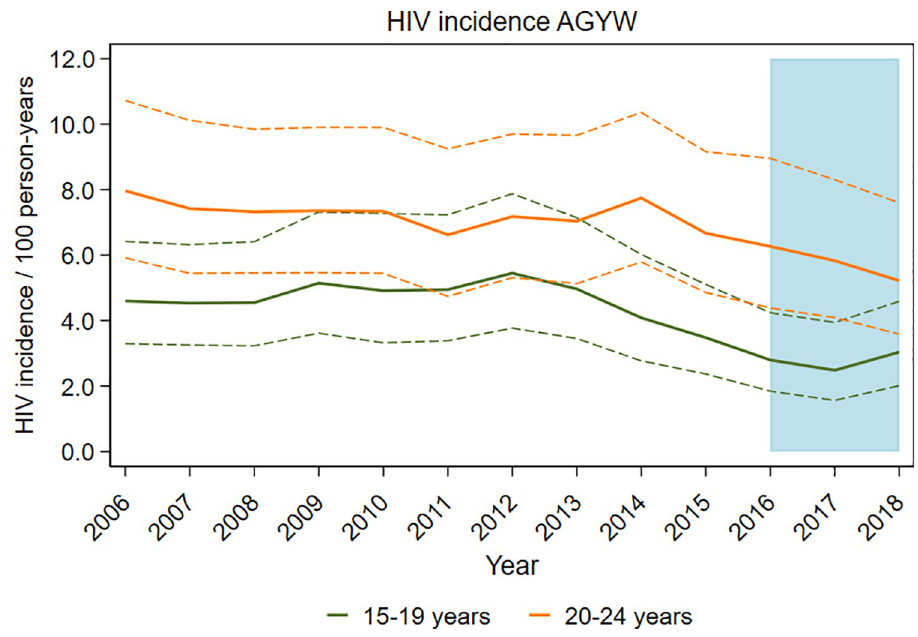
Fig 1. HIV incidence rates over time among AGYW with 95% CIs, in uMkhanyakude, South Africa. AGYW AU : AbbreviationlistshavebeencompiledforthoseusedinFigs 1 (cid:0) 4 : Pleaseverifythatallentriesarecorrect : , adolescent girls and young women; CI, confidence interval.